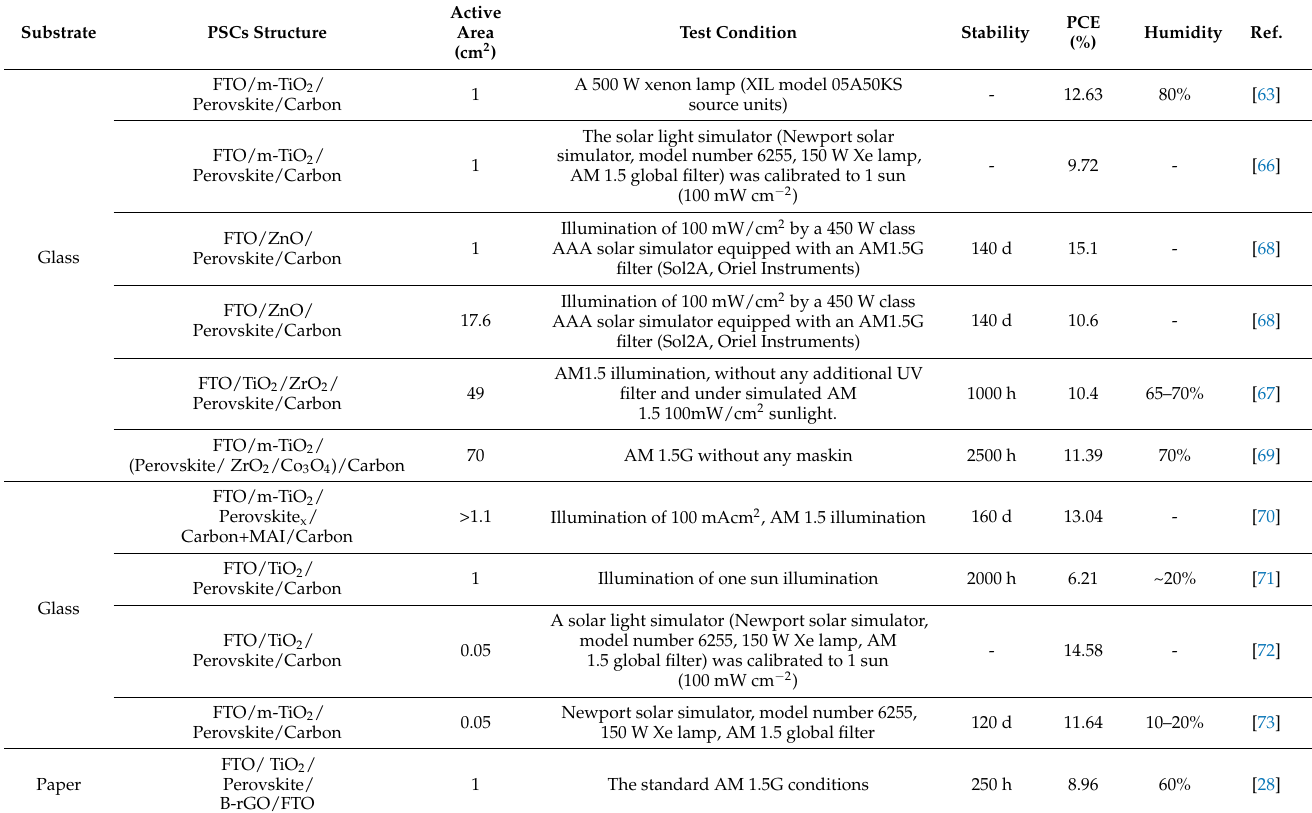
Table 2. Summary of several techniques to fabricate carbon electrodes in perovskite solar cells